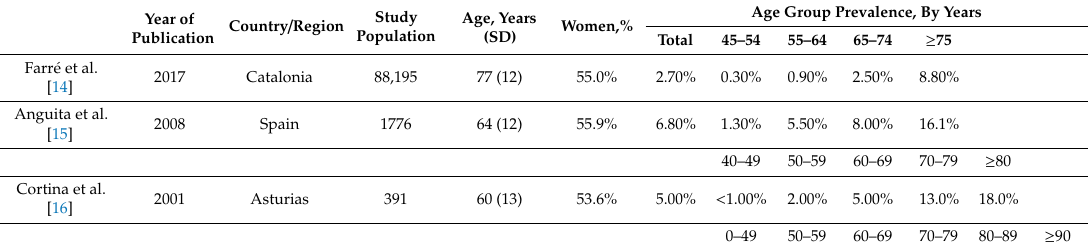
Table 2. Summary of the heart failure prevalence by age group in population studies in Spain and